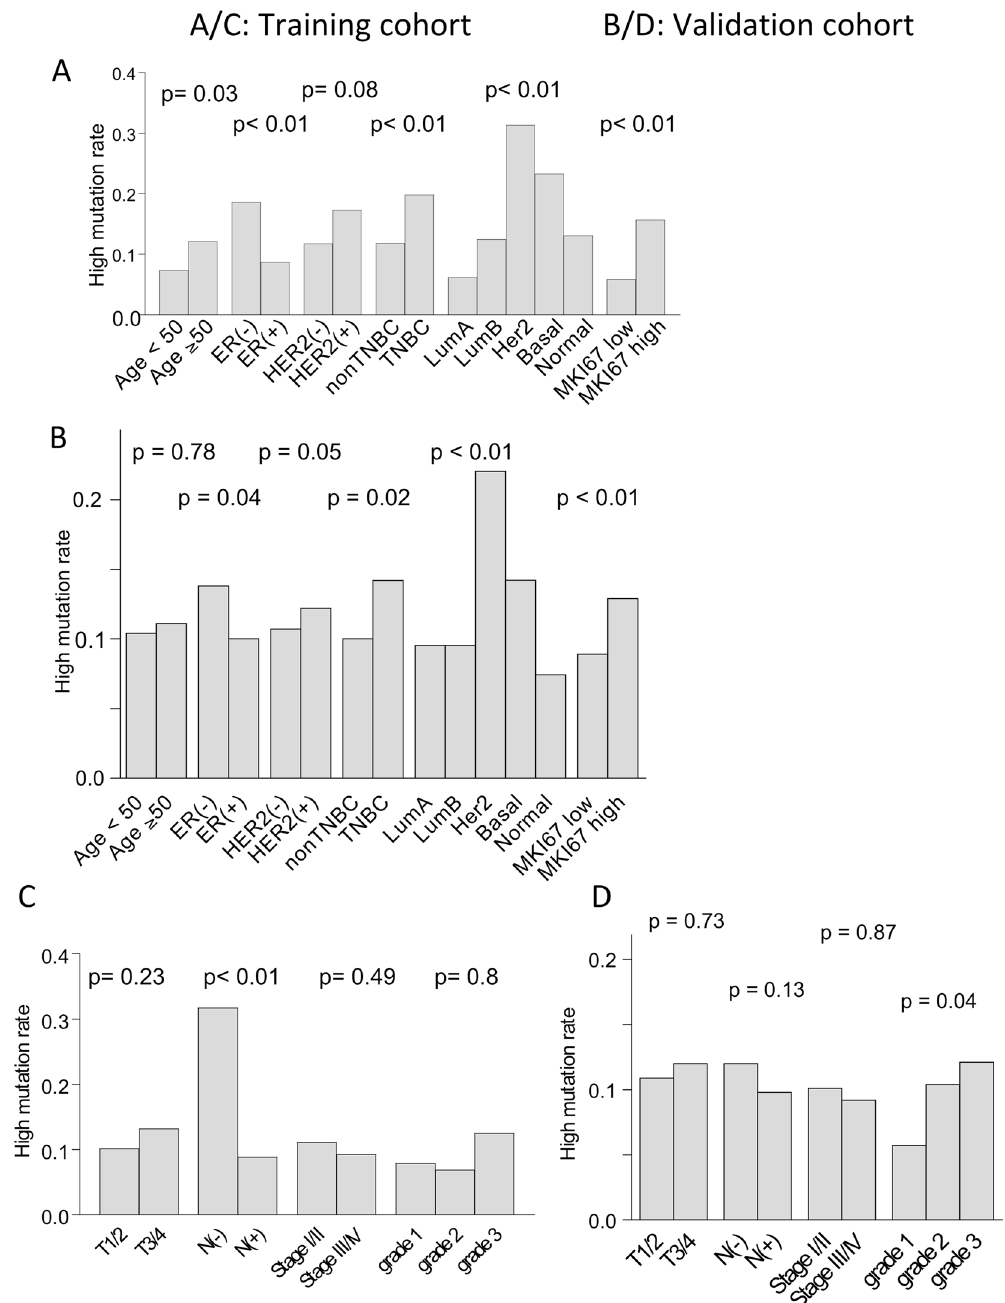
Figure 3. ( A ) Tumors with high mutation rates were more common in patients with age ≥ 50 (p = 0.03), ER ( − ) (p < 0.01), and TNBC (p < 0.01). Also, tumors with high mutation rates were more often in Luminal B, Her2, and Basal subtypes, compared to Luminal A subtype on PAM50 classification. Furthermore, tumors with high mutation rates demonstrated higher gene expression of MKI -67 (p < 0.01). ( B ) Similar results were noted in the validation cohort; higher mutation rates in ER ( − ) tumors (p = 0.04), TNBC tumors (p = 0.02), higher proportions in HER2 and Basal subtypes compared to Luminal A subtype on PAM50 classification (p < 0.01), and higher gene expression of MKI-67 (p < 0.01). ( C ) In the training cohort, tumors with high mutation rates were significantly associated with negative node status (p < 0.01), but not with AJCC T category (p = 0.23), pathological stage (p = 0.49), or histological grade (p = 0.8). ( D ) No difference in mutation rates in AJCC T (p = 0.73), N category (p = 0.13), or pathological stage (p = 0.87) in the validation cohort. Higher mutation rate was significantly more in the grade 3 tumors (p = 0.04). ER, estrogen receptor; TNBC, triple negative breast cancer; AJCC, American Joint Committee for